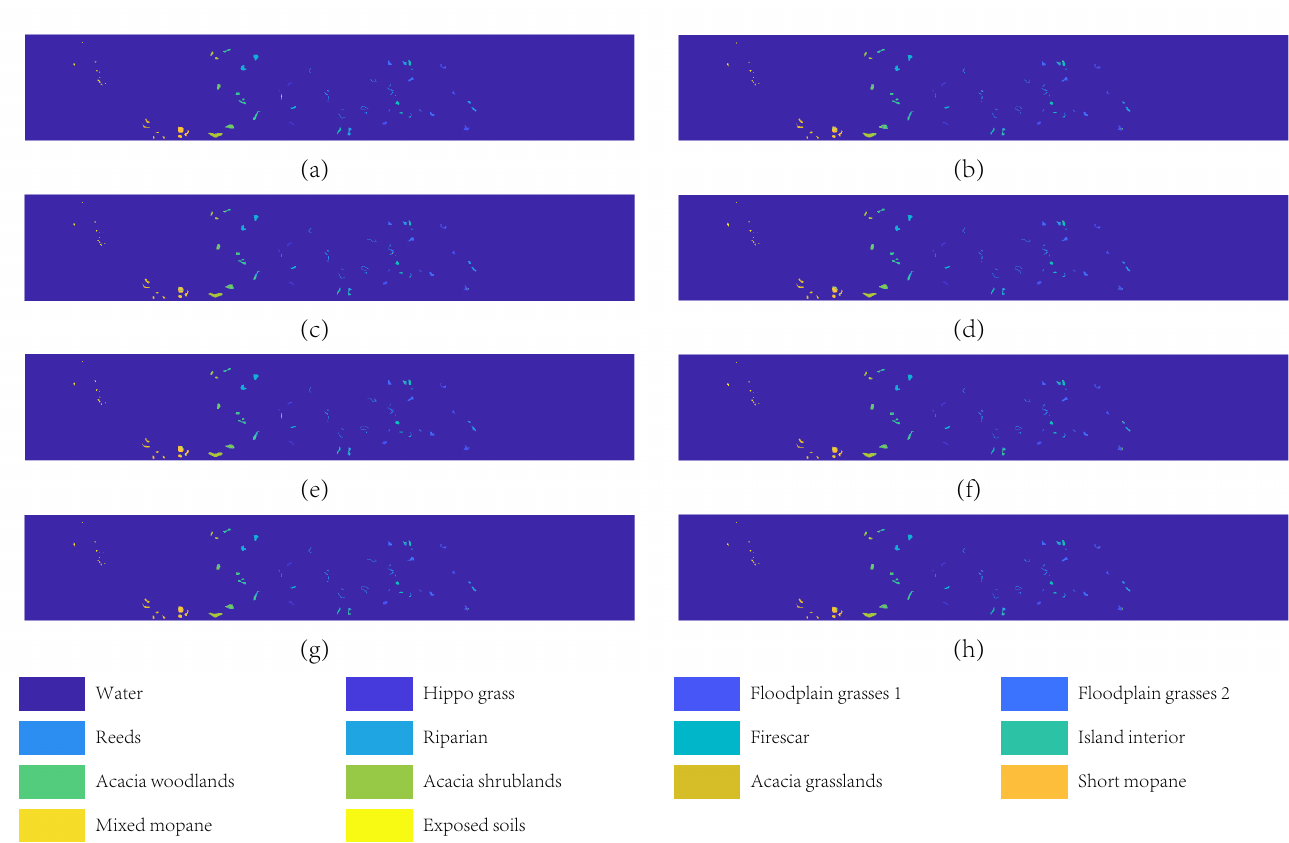
Figure 9. The visualization of classification on the Botswana dataset. ( a ) Ground truth; ( b ) UBS;